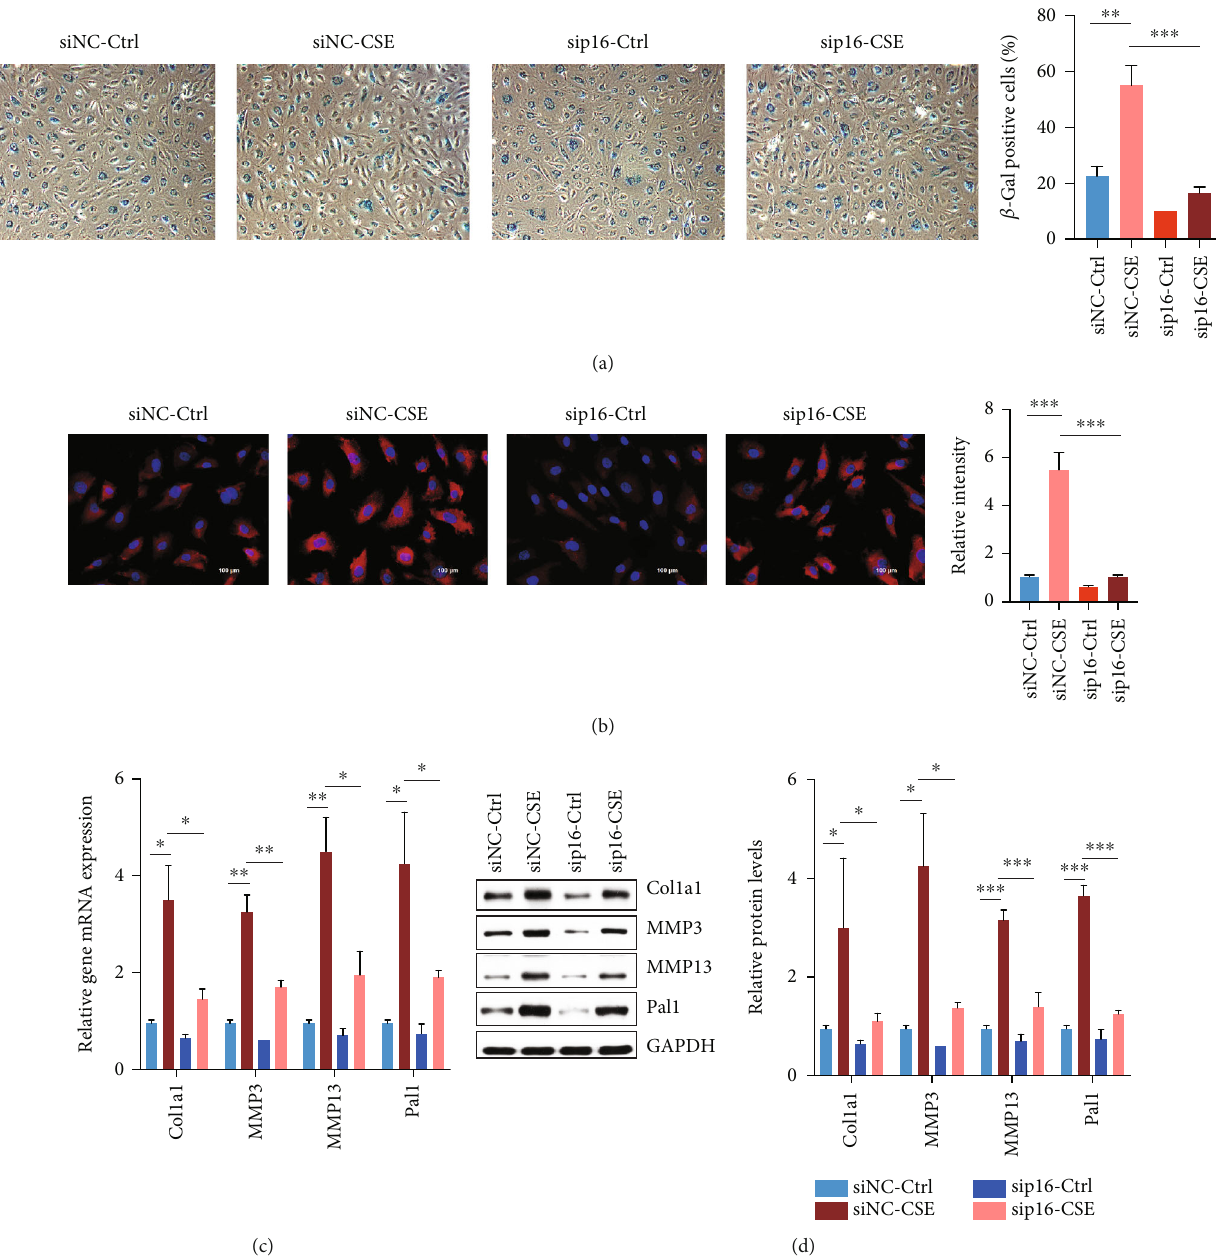
Figure 3: CSE-mediated high expression of p16 promoted cell senescence. (a) Peripheral blood EPCs from nonsmoking non-COPD patients were treated with 5% CSE, p16 was knocked down by siRNA, and the proportion of senescence cells was counted by β -galactosidase staining. (b) Peripheral blood EPCs from nonsmoking non-COPD patients were treated with 5% CSE, p16 was knocked down by siRNA, and the expression of Lamp1 was detected by immuno fl uorescence. (c) Peripheral blood EPCs from nonsmoking non-COPD patients were treated with 5% CSE, p16 was knocked down by siRNA, and the expressions of senescence-related genes Col1a1, MMP3, MMP13, and Pal1 were detected by RT-PCR. (d) Peripheral blood EPCs from nonsmoking non-COPD patients were treated with 5% CSE, p16 was knocked down by siRNA, and the expressions of senescence-related genes Col1a1, MMP3, MMP13, and Pal1 were tested by Western Blot. ∗ p < 0 : 05 , ∗∗ p < 0 : 01 , and ∗∗∗ p < 0 : 001